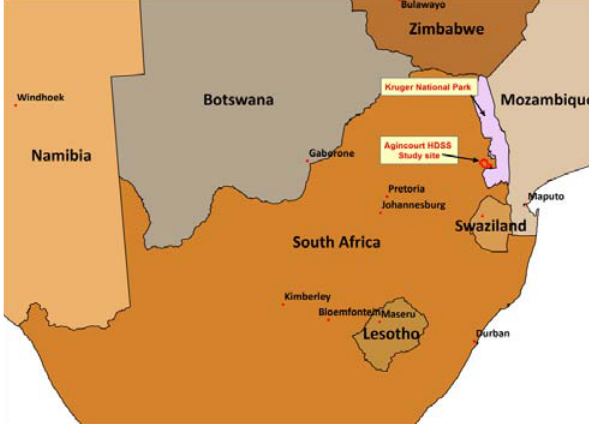
Figure 1. The location of the Agincourt HDSS in the South Africa and the surrounding